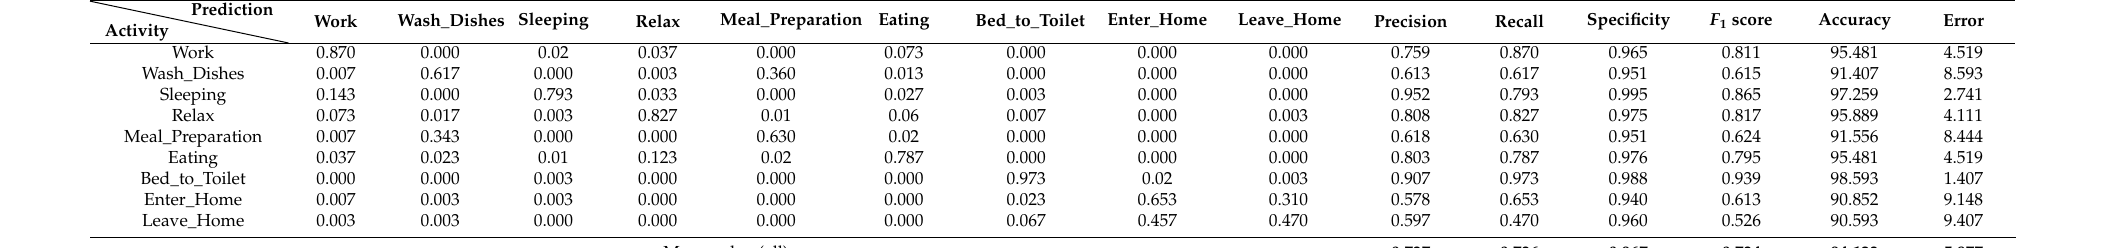
Table 4. Confusion Matrix for Activities and Evaluation of model without Previous Activity Feature.